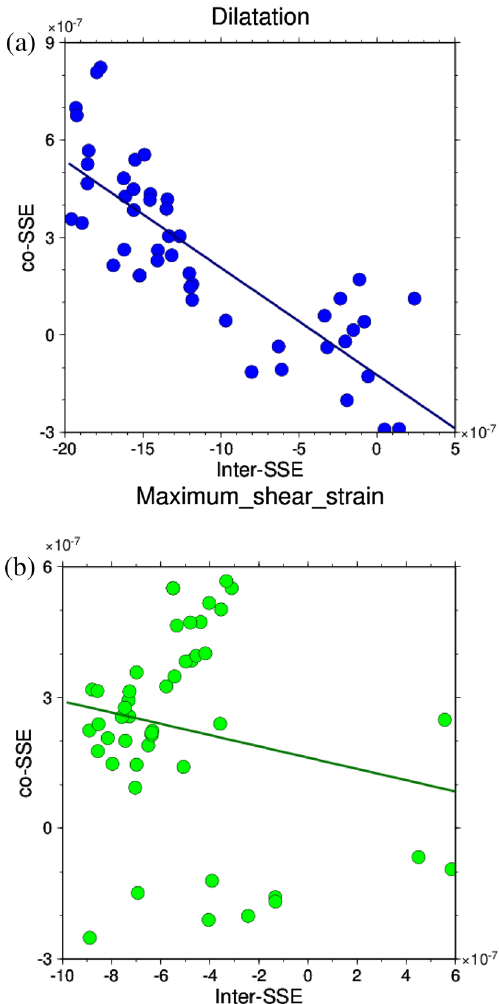
Figure 3. Correlation diagram between the amount of accumulated strain before the Bungo Channel L-SSE (1) (7 August 2004–24 November 2009) and the amount of change in strain during the L-SSE occurrence (25 November 2009–6 February 2011). The values of dilatation and the maximum shear strain at the calculation points shown in Fig. S2c are used. The straight line represents the linear regression line. ( a ) Dilatation. ( b ) Maximum shear